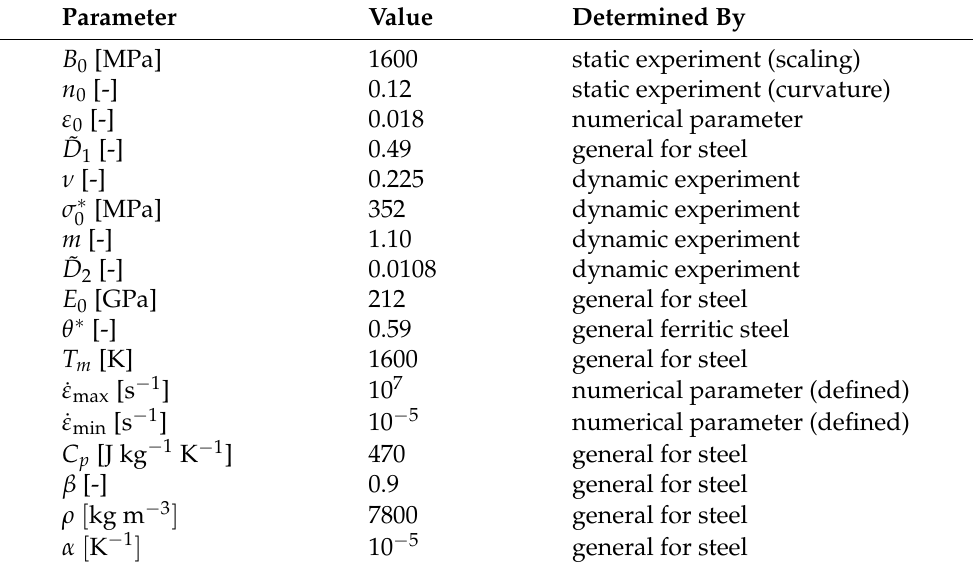
Table 2. Estimated RK parameters determined: static behaviour according to test data [21] and the dynamic behaviour, according to Lee and Yeh